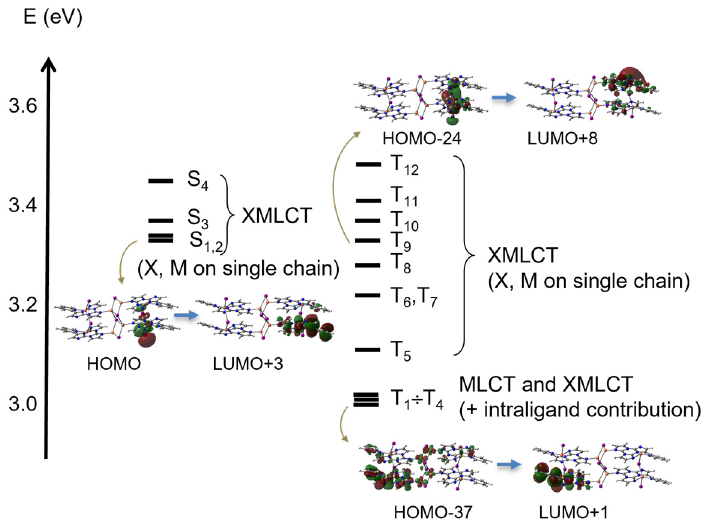
Figure 5. Electronic levels computed for the model compound of [Cu 2 I 2 ( TT-Py ) ] n and MOs mainly involved in the S 1 , T 1 and T 9 transitions [51].